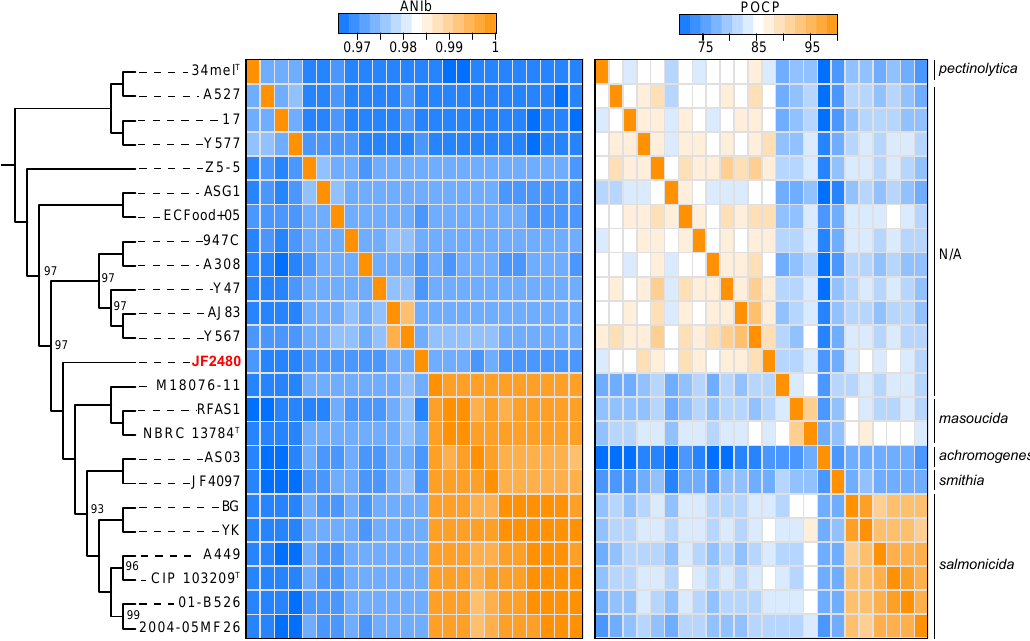
Figure 2. Cladogram showing the phylogenetic relations between JF2480 and other A. salmonicida strains. Only bootstrap values inferior to 100 are shown at the corresponding nodes. The heatmap represents the ANI values (in the middle) and the POCP values (on the right).